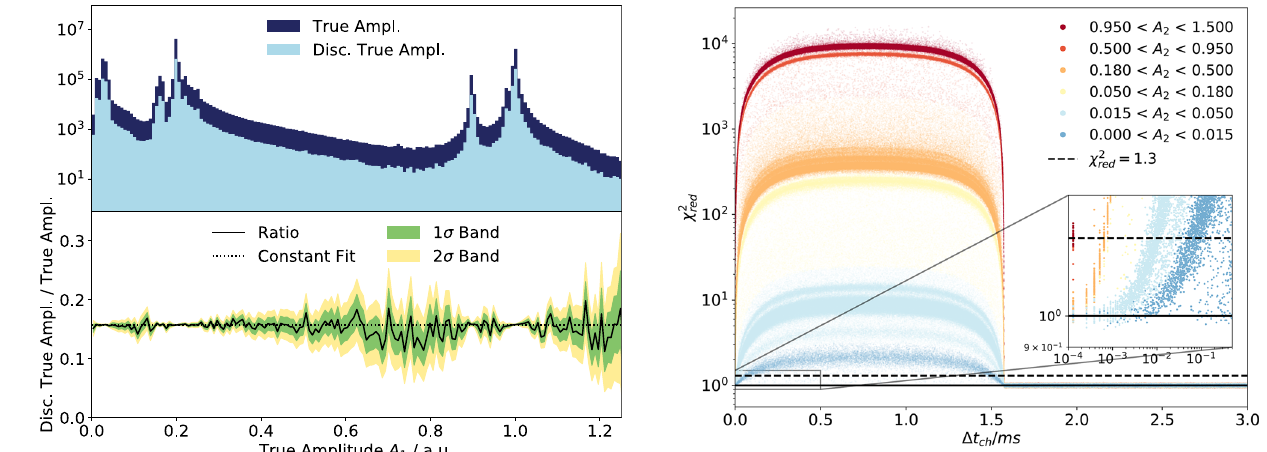
Fig. 10 Upper panel: histogram of true amplitude A 1 of the simulated pileup events that are discarded by the pulse shape filter compared to the histogram of all simulated true amplitudes A 1 . Lower panel: ratio of the two histograms and the corresponding uncertainty bands due to the Poisson error of the number of counts in each bin. The ratio agrees well with a constant fit, which indicates that PIT events are discarded by a pulse shape filter in an energy-independent way